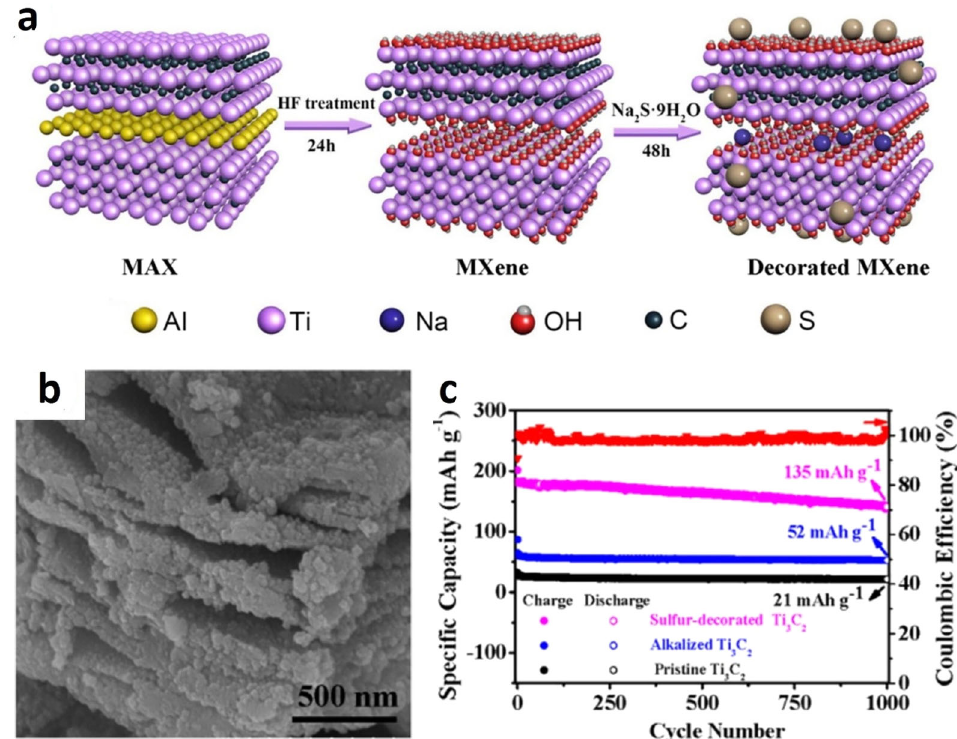
Fig. 11 Performance of sulfur-decorated Ti 3 C 2 MXene. a Graphical representation of the synthesis of S-decorated Ti 3 C 2 MXenes. b SEM image of S-Ti 3 C 2 MXenes. c Cycling performance and coulombic ef fi ciencies S-Ti 3 C 2 MXenes and alkali-rich Ti 3 C 2 Mxenes at a current density of 2 A g − 1 . a – c used with permission from Elsevier B.V./Sun 150